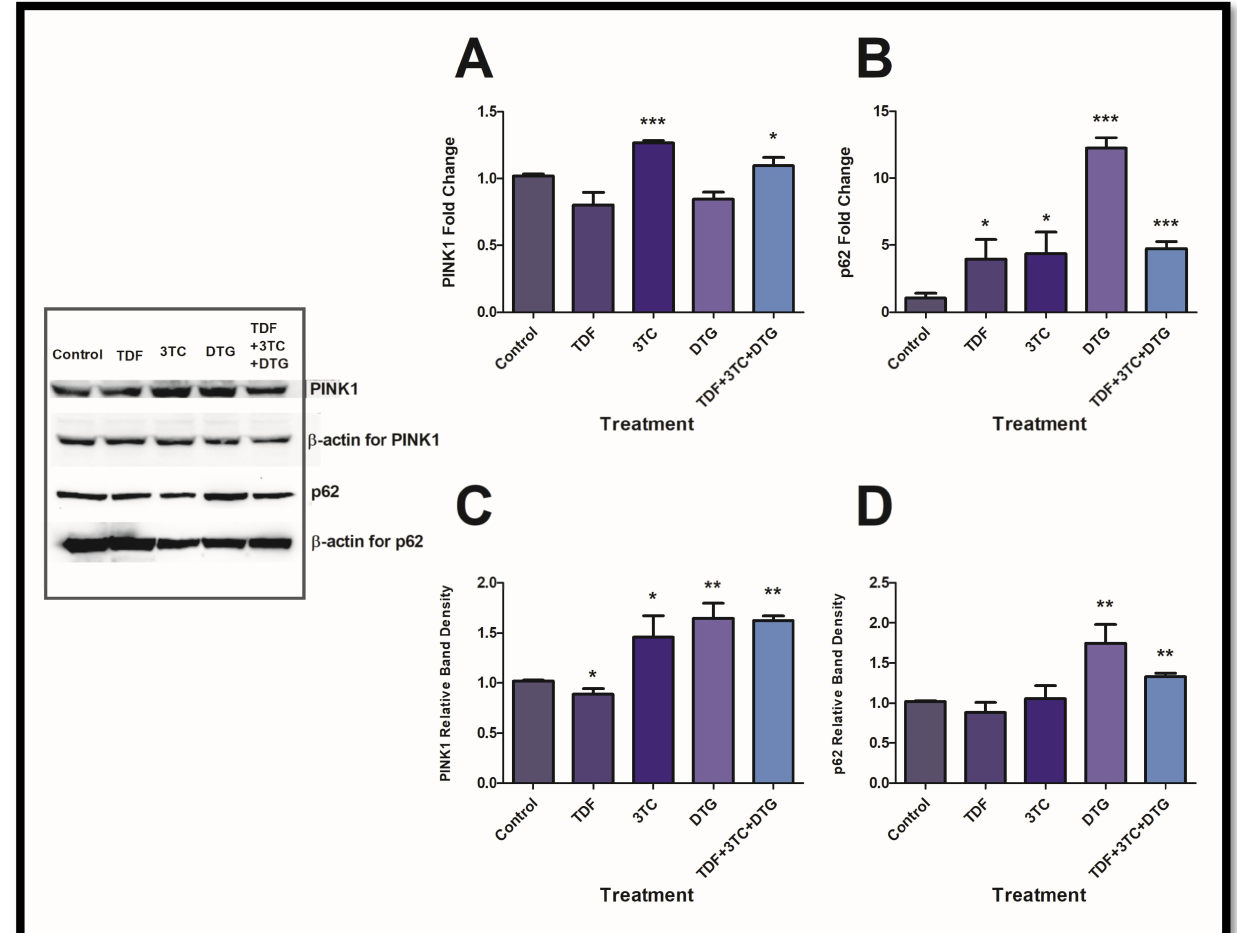
Figure 2. Transcript and protein expression of mitochondrial maintenance components. PINK1 mRNA expression ( A ) and protein expression ( C ) as elevated for selected ARV treatments. Signif- icant increases in p62 mRNA expression were observed for all treatments ( B ); however, only DTG and combinational usage showed considerable increases in p62 protein expression ( D ). * p < 0.05, ** p < 0.005, *** p < 0.0001 relative to control (Raw blot images are available in Supplementary Materi- als: Figures